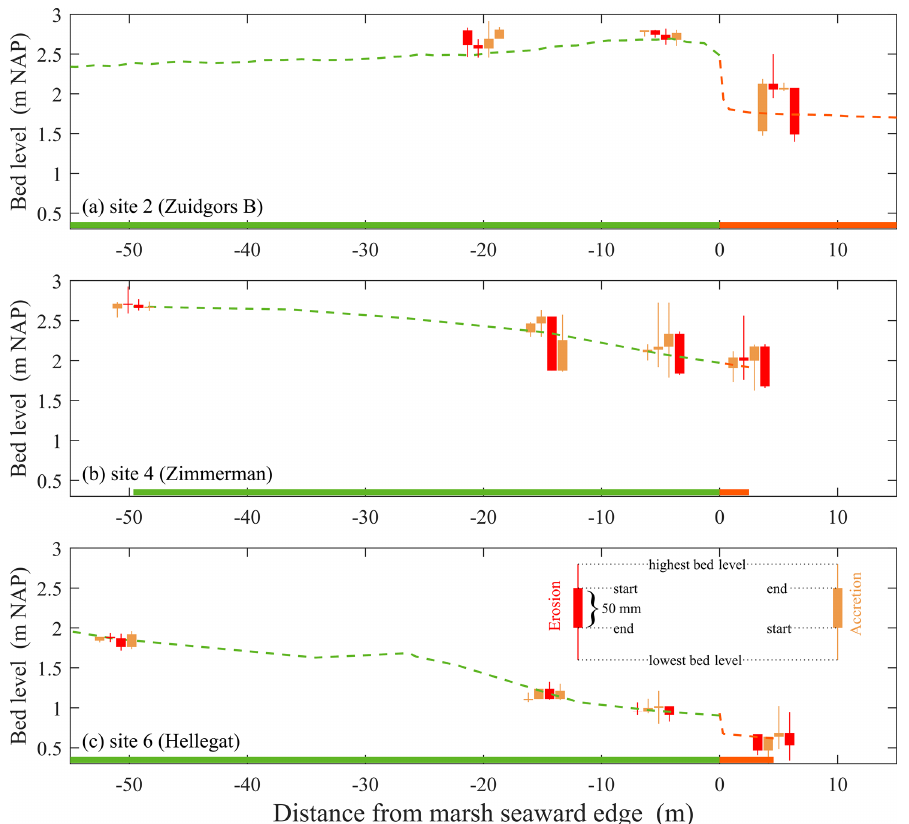
Figure 4. Seasonal bed-level changes at (a) site 2 (Zuidgors B), (b) site 4 (Zimmerman), and (c) site 6 (Hellegat) with bathymetry data (dashed green line). At each SED sensor station, the four bars from left to right indicate bed-level changes in spring (March–May), summer (June–August), autumn (September–November), and winter (December–February). The red bars indicate net erosion, and the yellow bars indicate net accretion. The observed highest and lowest bed levels in a season are indicated by the top and bottom of the